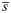
Sentiment bars of the ‘thumbs down sign’, ‘flushed face’, and ‘chocolate bar’ emojis.The colored bar extends from −1 to +1, the range of the sentiment score s¯. The grey bar is centered at s¯ and extended for ±1.96SEM, but never beyond the range of s¯. Colored parts are proportional to negativity (p
−, red), neutrality (p
0, yellow), and positivity (p
+, green).